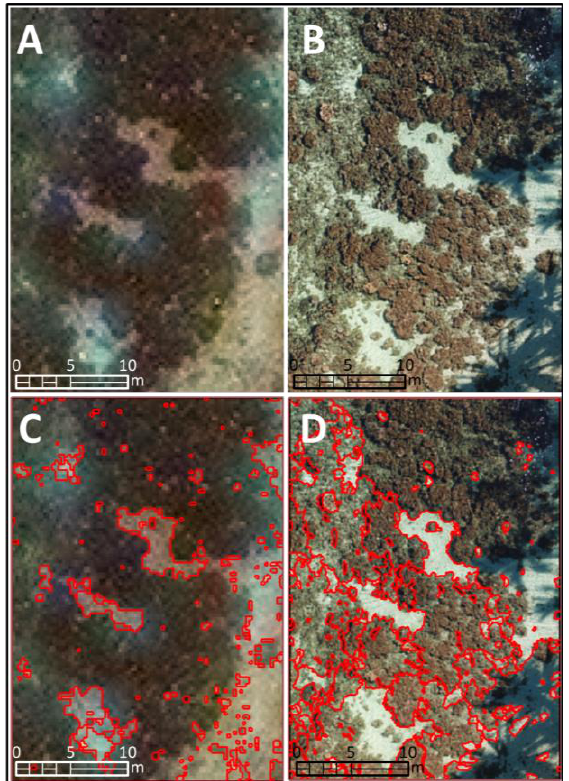
Figure 6. Comparison of a fringing reef subset of natural- coloured (A) WorldView-3 (0.3 m pixel size) and (B) UAV (0.1 m pixel size), as well as segmented (C) WorldView-3 and (D) UAV